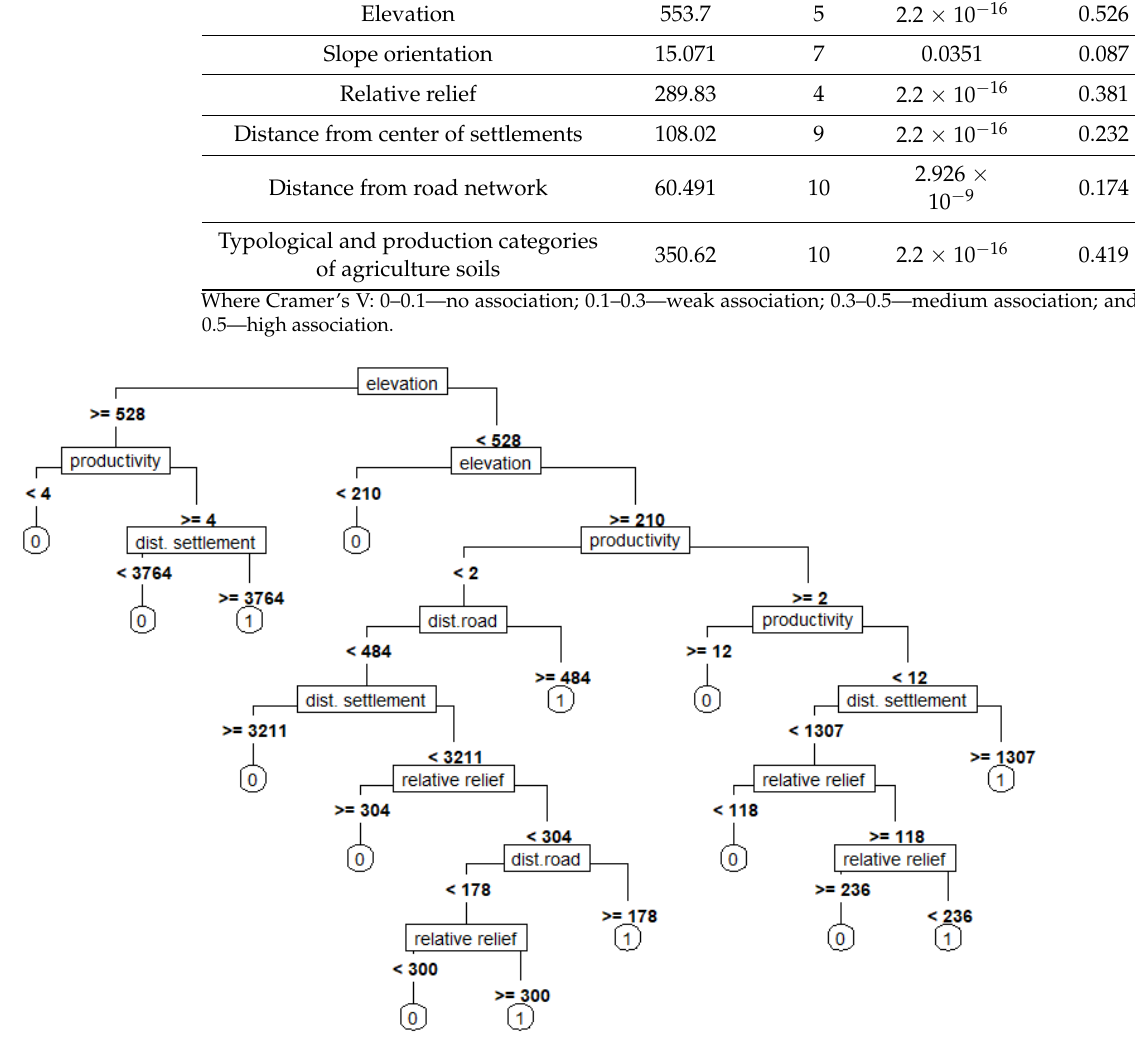
Figure 3. Tree-based model of dependency between silvopastoral historical presence and evaluated environmental variables. Zero is interpreted as a low probability (below 50%) to be wood pasture, and one means a higher probability (above 50%) to be wood pasture. Numbers below 0 and 1, e.g., 325/9 on the far left, mean how many points met the criteria of 0 (before the slash) or 1 (after the slash).